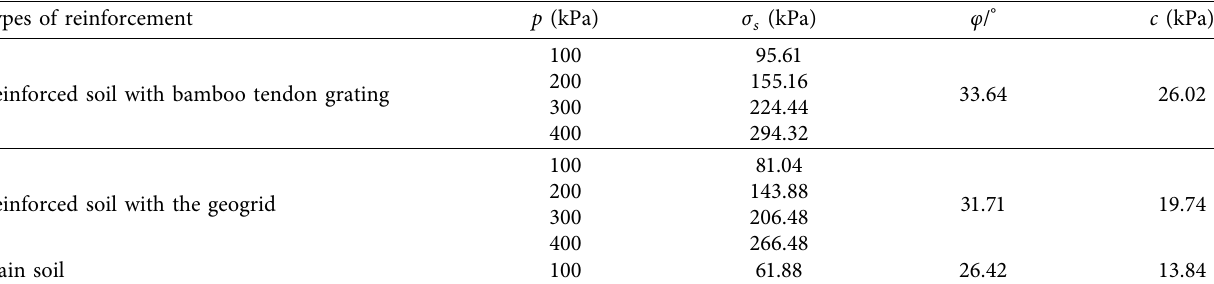
Figure 14: Relationship between shear strength and normal stress levels of different reinforced materials. Table 10: Test results of interface friction between reinforcement and